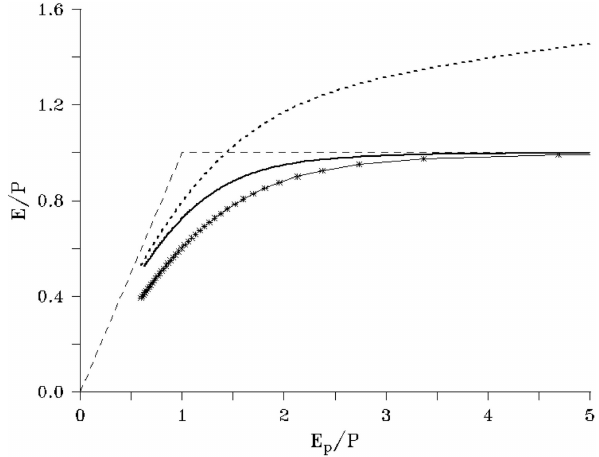
Figure 10. Comparison of Budyko curves for the baseline (solid) and I = 2mmday − 1 (dotted) configurations. Also shown is a Budyko-like curve in which E is replaced by E ∗ = E − I